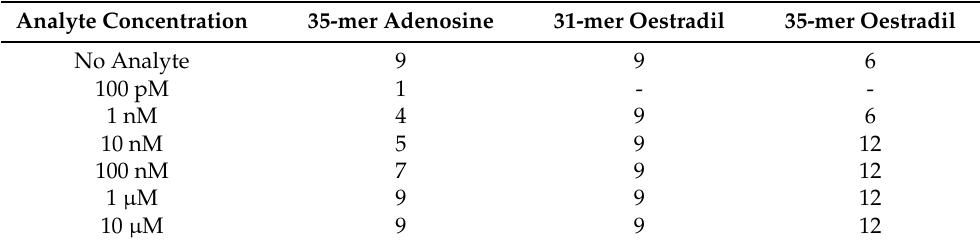
Table 5. The number of available segments for each dataset after removing the contextual outlier signals and segments.